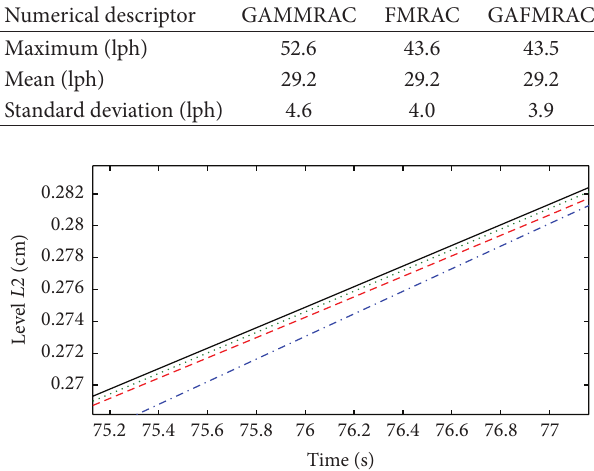
Table 4: Statistical analysis of different controller outputs.